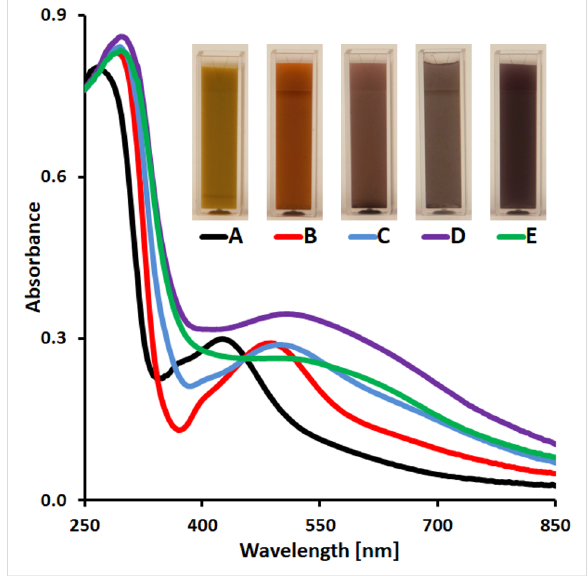
Figure 4: UV–vis spectra and images of aqueous suspensions of freshly prepared Ag–TiO 2 core–shell nanostructures (A) and after annealing in 150 °C for 0.5 h (B), 1.5 h (C), 3 h (D) and 12 h (E).